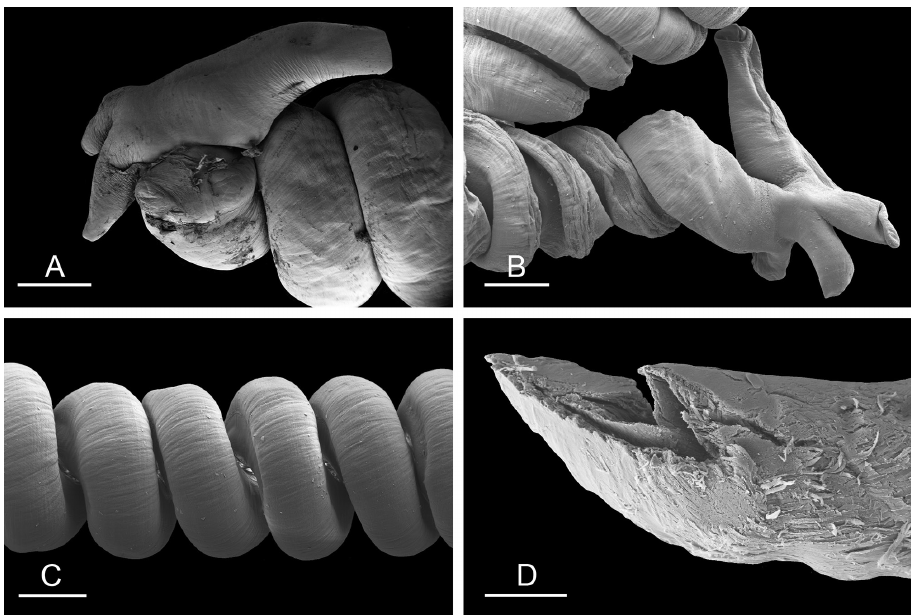
Figure 42. Penis, Wallaconchis ater , Indonesia. A Detail of distal portion when fully relaxed (with distal penial projections) and partial view of the coil, Indonesia, Halmahera, scale bar 500 μm [3393] (PNM 041218) B Detail of distal portion when fully relaxed (with distal penial projections) and partial view of the coil, Halmahera, scale bar 500 μm [5125] (UMIZ 00054) C Partial view of the coil (with six loops), Philippines, Bohol, scale bar 500 μm [3266] (PNM 041214) D Cross-section showing the longitudinal fold, Bali, scale bar 300 μm [3137] (UMIZ